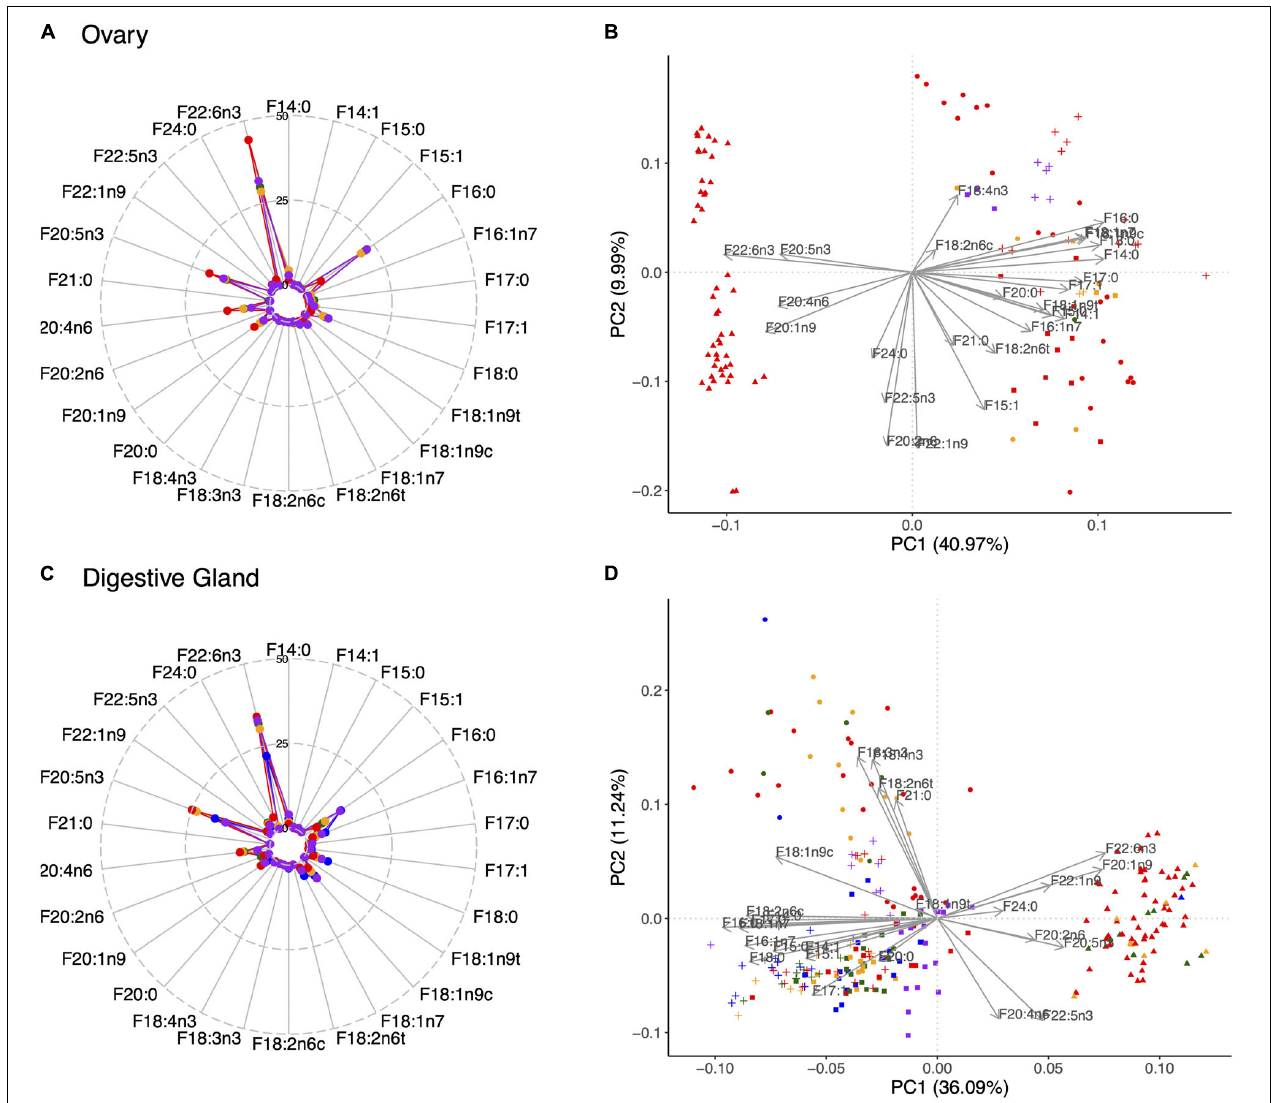
FIGURE 6 | Radar plots showing the percentage of each of the analyzed fatty acids (FA) across maturity stages in the ovary (A) and digestive gland (C) . (B,D) Illustrate the principal component analyses in the ovary and digestive gland, respectively, showing the contribution of each analyzed FA across maturity stages and sampled years. Legend coding as in Figure 5 .